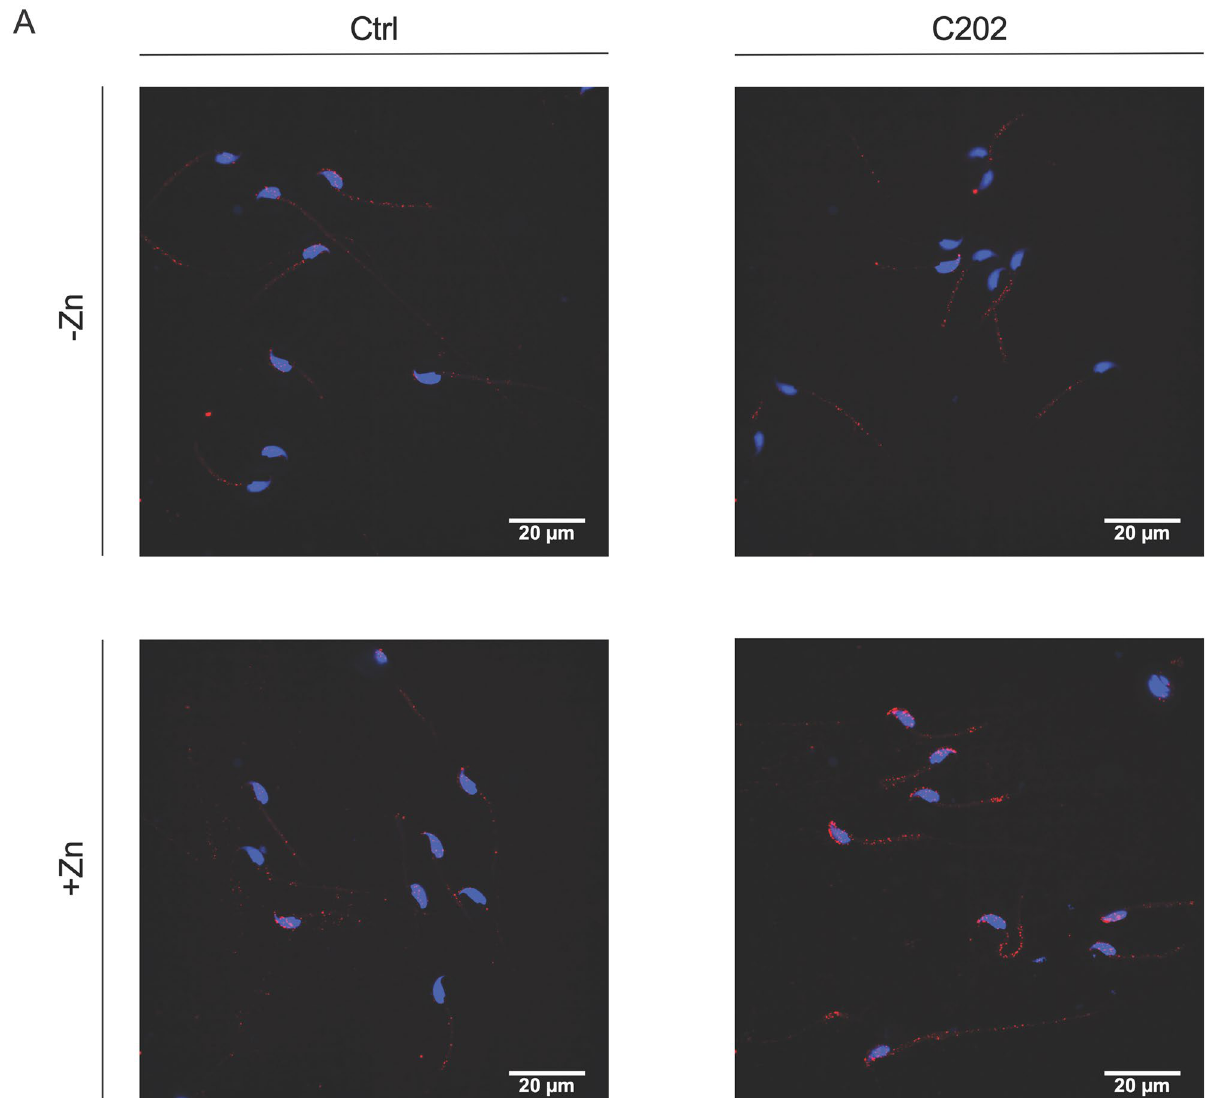
Figure 4. CD63-HA facilitated visualization and confirmation of interactions between DC2 epididymal epithelial cell EVs and sperm. ( A ) Immunofluorescent confocal microscopy identified anti-HA staining (red) in the head (blue) and midpiece of sperm incubated with EVs isolated from conditioned media from CD63-HA EVs (C202), but not Ctrl EVs. As expected, the presence of EVs as detected with this anti-HA staining in sperm was dependent on media supplementation with 1 mM ZnCl to mimic the intraluminal environment of the epididymis. ( B ) Immunogold transmission electron microscopy confirmed the presence of CD63-HA EVs with sperm incubated specifically with C202 EVs at the resolution of single epitopes (labeled with white arrow